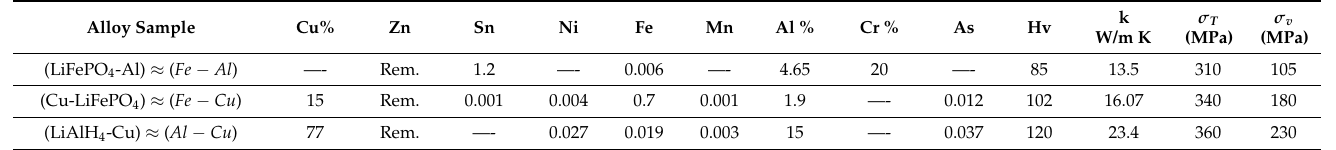
Table 1. The main components of three candidate alloys of TEG